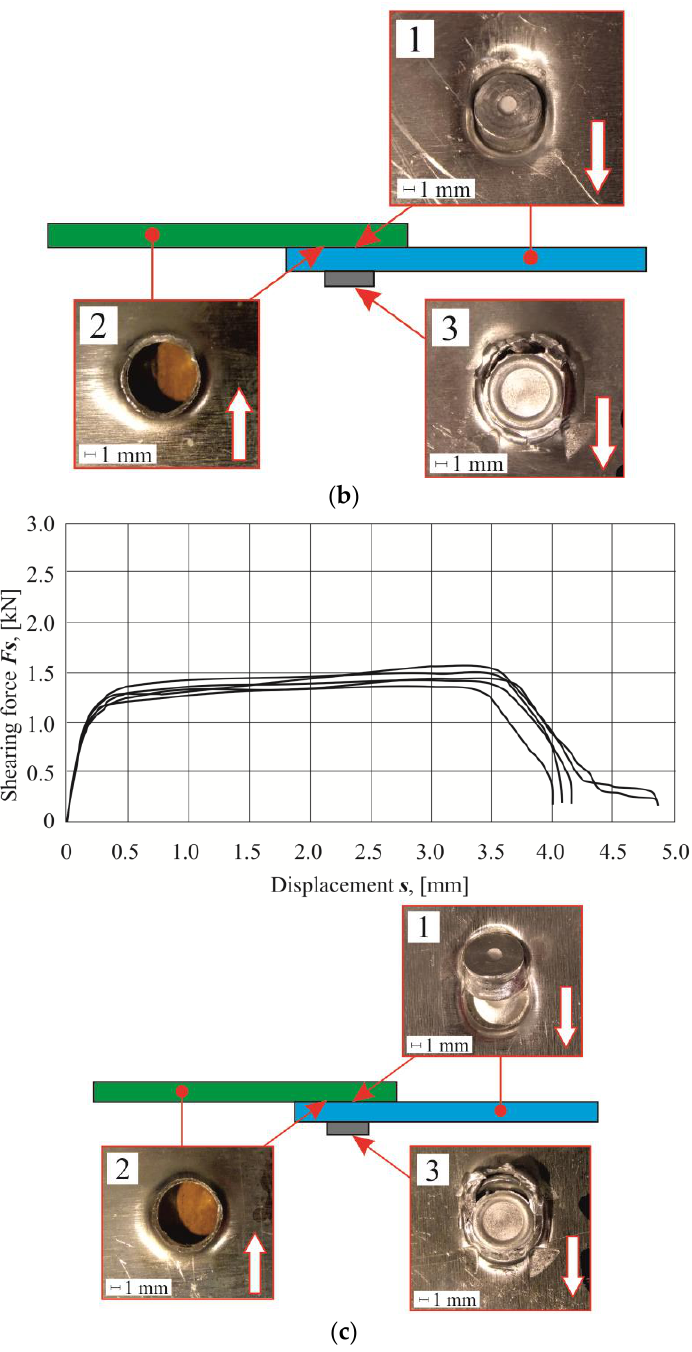
Figure 16. The tensile shear force-displacement diagrams (left side) and joint fragments after tensile shear test: ( a ) arrangement no.3 (AW 6082 with AW 5754-H11), ( b ) arrangement no.6 (AW 6082 with AW 5754-H22), ( c ) arrangement no.9 (AW 6082 with AW 5754-H24).